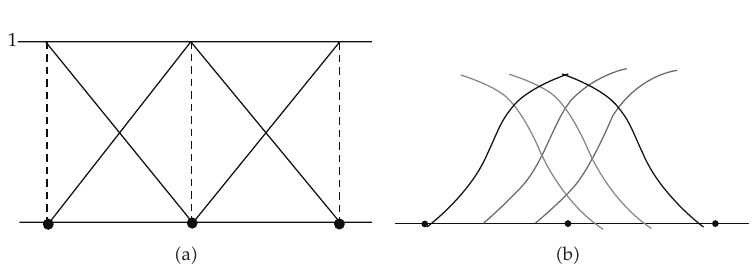
Figure 1: Shape functions of (cid:2) a (cid:3) FEM and (cid:2) b (cid:3) FMLSRKM. A shape function of FEM is a partition of unity, but that of FMLSRKM is not.